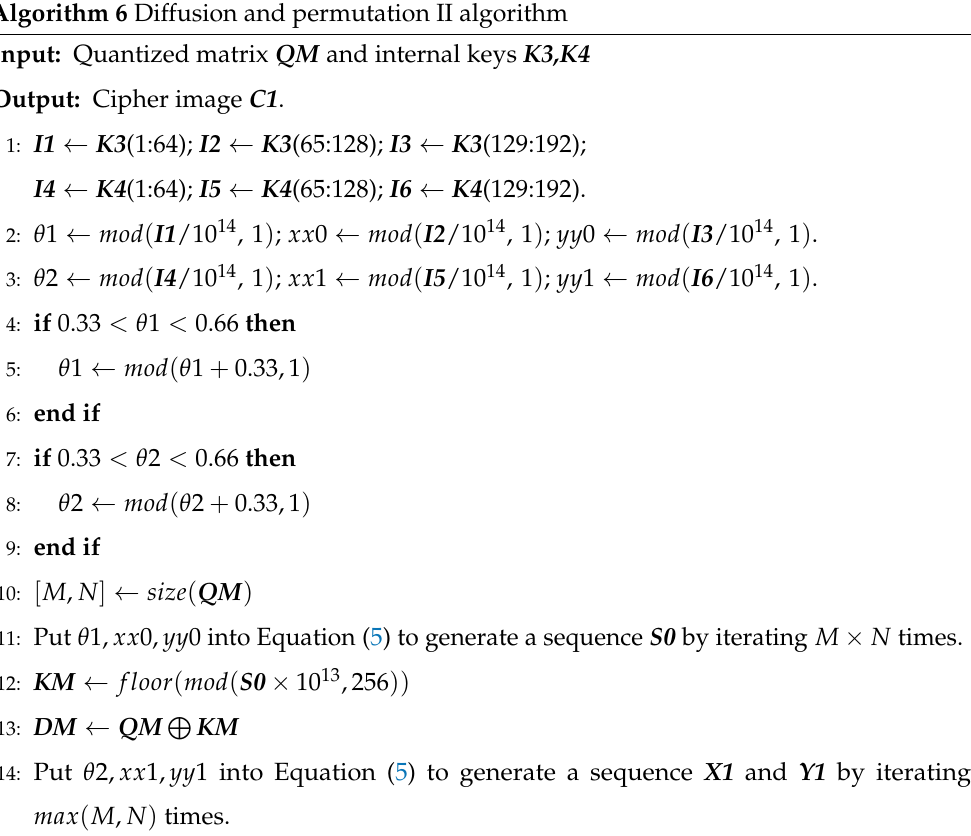
Algorithm 6 Diffusion and permutation II